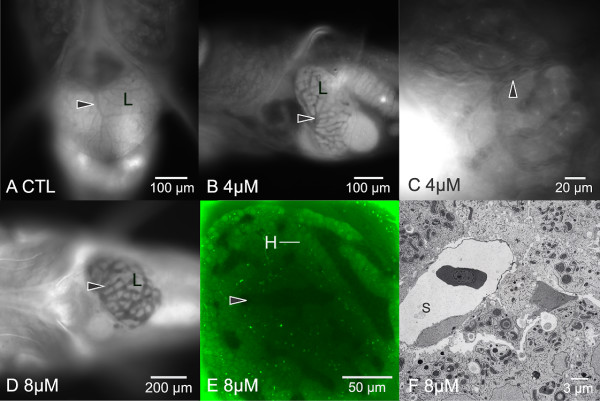
In vivo imaging of hepatobiliary toxicity: passive hepatic congestion. (A) Widefield fluorescence DAPI/UV, control liver, 20 dpf, showing the normal in vivo appearance of hepatic vasculature (black arrowhead). Vasculature appears dark (non fluorescent). Epithelium of parenchyma appears light gray. (B and C) At 4 μM ANIT, 24 hrs post exposure, modest dilation of hepatic vasculature was observed throughout the liver (black arrowhead). Image B is DAPI/UV (autofluorescence), image C is TRITC (autofluorescence). (D) At 8 μM ANIT, 24 hrs, marked dilation of the intrahepatic vasculature was observed (DAPI/UV). (E) In vivo confocal imaging, acquired at 48 hrs post ANIT exposure, confirmed dilation of intrahepatic vasculature (black arrowhead) was a pan-hepatic response, occurring uniformly throughout the liver. Vasculature is dark gray, hepatocytes (H) appear green. (F) Transmission electron micrograph (8 μM, 20 dpf, 48 hrs post exposure) of an intrahepatic vessel in ANIT treated medaka, revealing abnormal sinusoid/endothelial cell morphology (S). A single red blood cell can be seen in the sinusoid lumen. Endothelium is highly attenuated. In tandem with morphological changes were changes to cardiovascular function; decreasing heart rate and motility along with increase in vasodilation, in medaka exposed to 0.5 μM to 8 μM ANIT. Control heart rates averaged 129 bpm to 140 bpm (n = 12). Heart rate decreased with increasing ANIT concentrations. At 8 μM ANIT heart rate (means) was observed to be 118 bpm at 6 hrs post exposure, 73 bpm at 24 hrs post exposure, and 61 bpm at 48 hrs post exposure. At dosage regimes above 4 μM (acute and chronic), vasodilation of the hepatic vasculature was evident. Dilation of sinusoids, hepatic vein, and hepatic portal vein, were all observed. Sinusoid diameters: control sinusoids averaged 7.4 μm. At 8 μM ANIT, 48 hrs post exposure, sinusoid diameter averaged 15.3 μm.